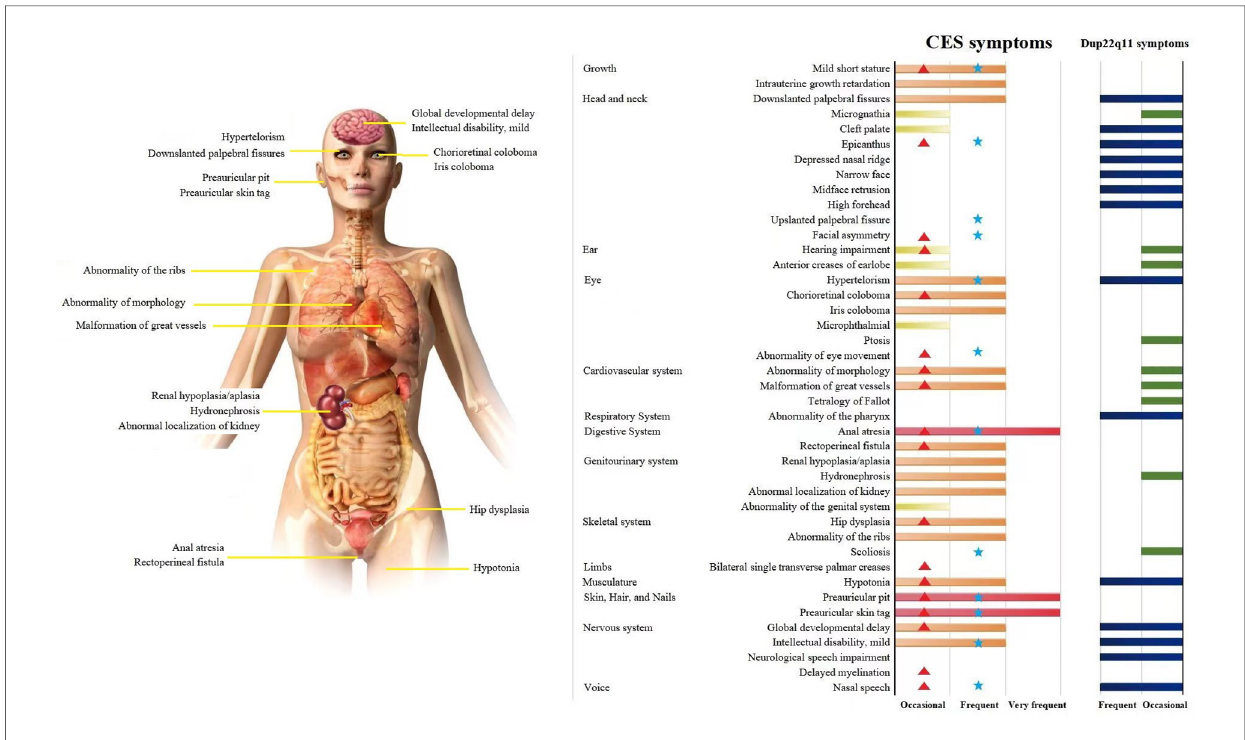
FIGURE 4 CES affects multiple systems and organs. A Comparison of CES and dup22q11 symptoms in the proband and father. Note: Symptoms and data source: OMIM, HPO, Orphanet, and 131 papers on CES published between 2001 and 2021. The frequency in the patient population: